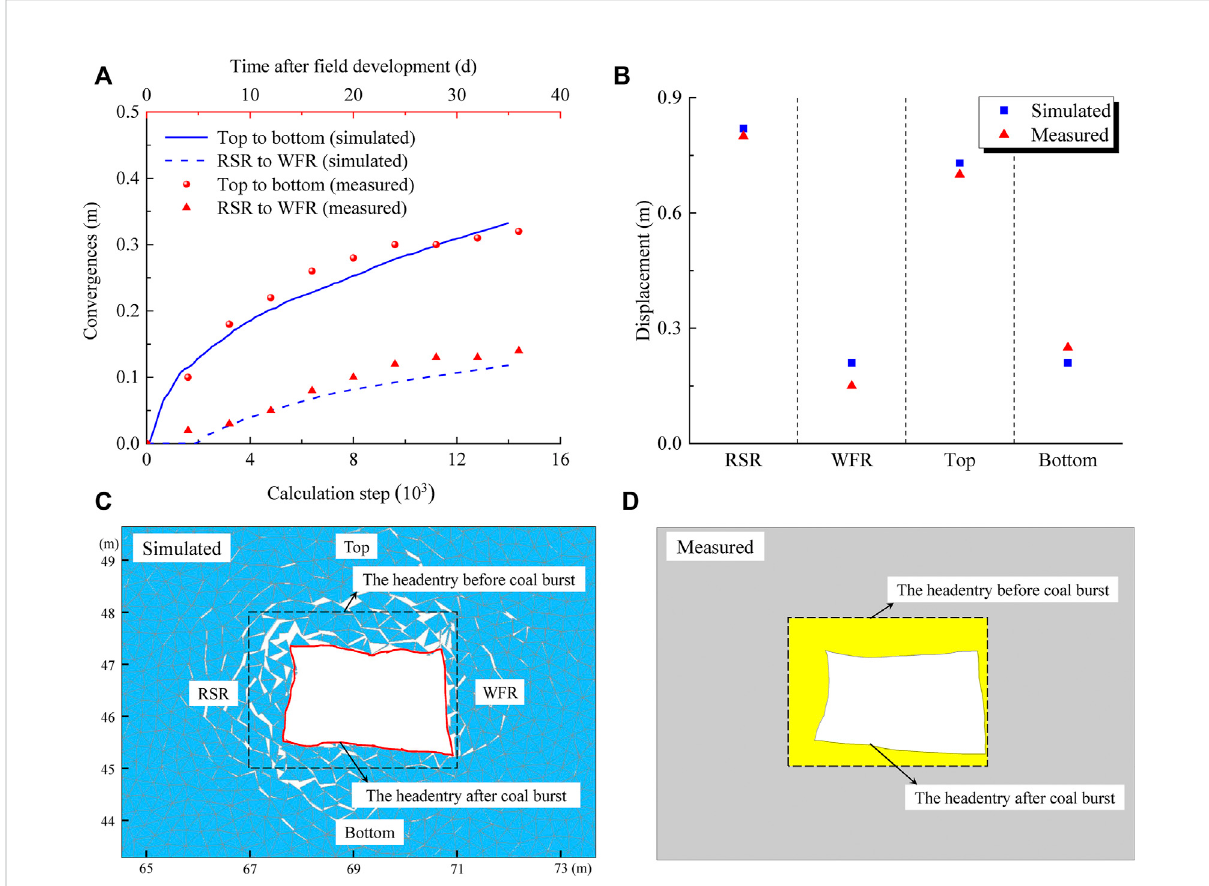
FIGURE 6 Validation of the UDEC-Trigon model: (A) convergence of the headentry, (B) displacement in the MSTCB, (C) simulated results of the MSTCB, and (D) measured results of the MSTCB.